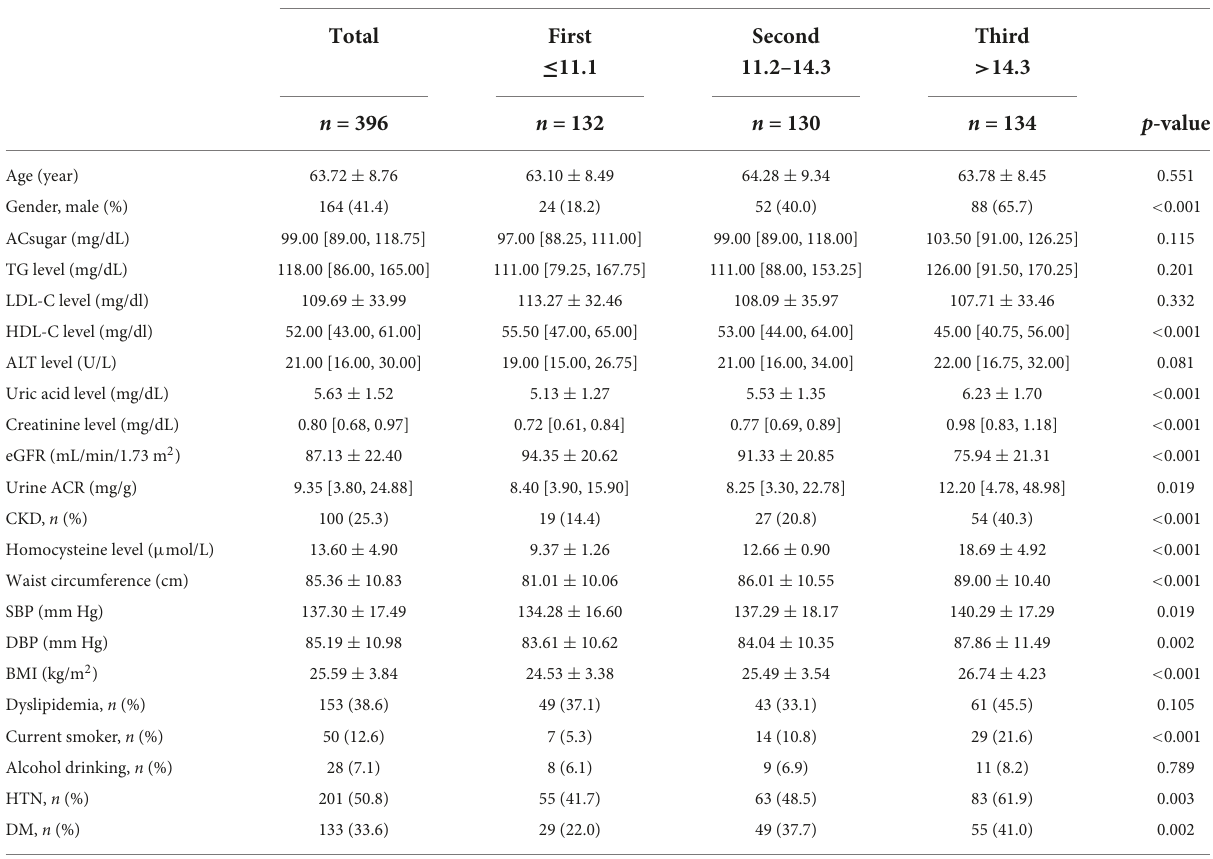
TABLE 1 General characteristics of the study population according to tertiles of homocysteine